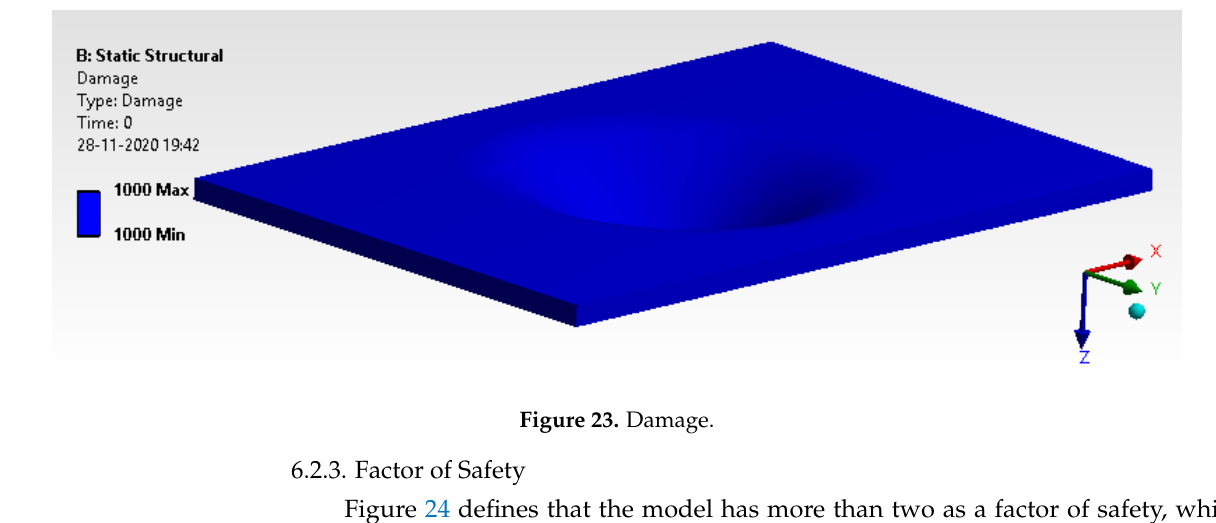
Figure 23. Damage. Figure 23. Damage.